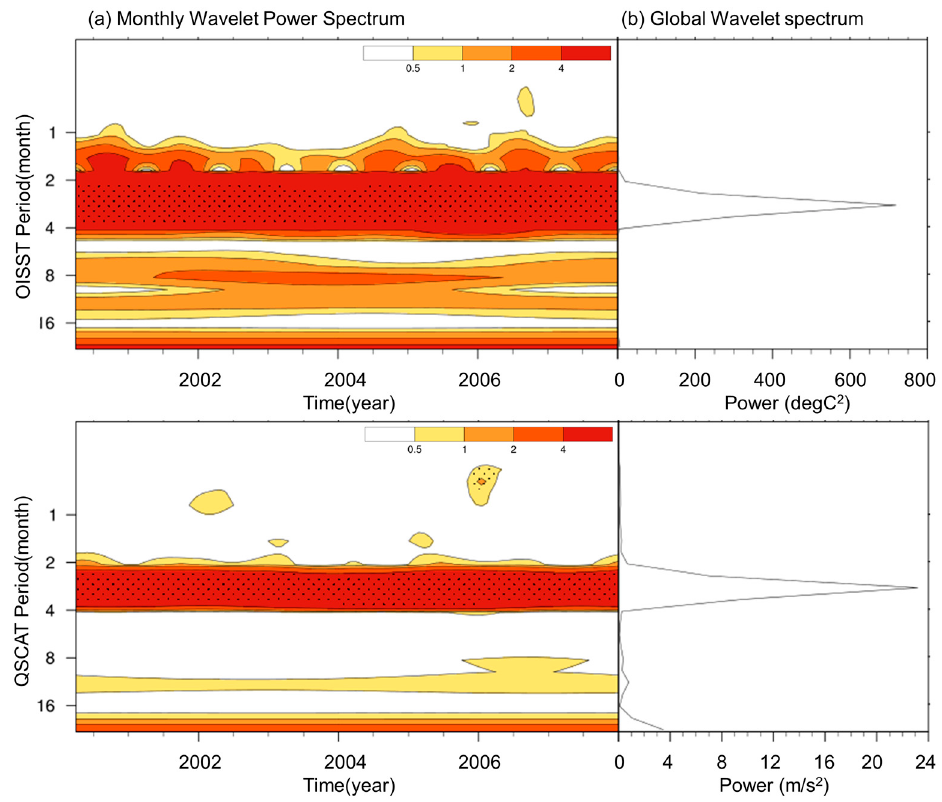
Figure 4. Spectral analysis of OISST and QSCAT wind speed during the same analysis period. The hatched area in the wavelet spectrum represents significant energy at a 95% confidence level.